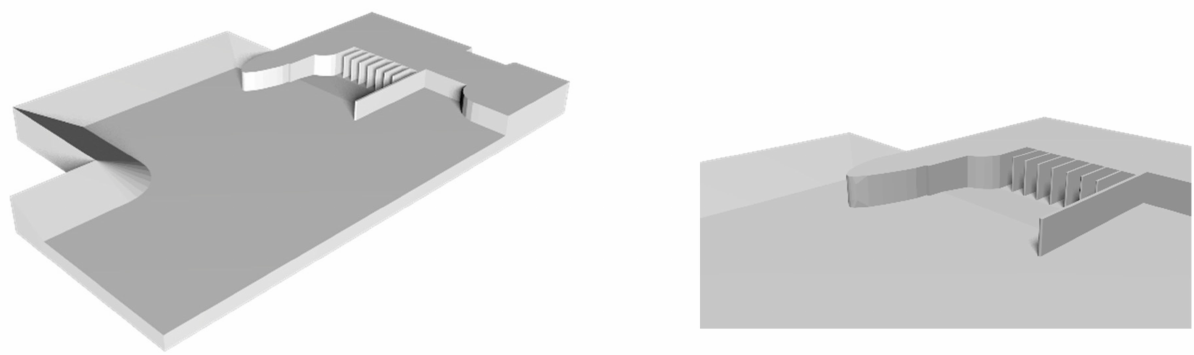
Figure 4. 3D model of the numerical simulation